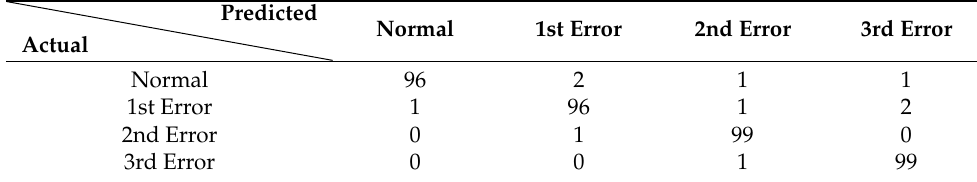
Table 2. Confusion matrix of the fifth